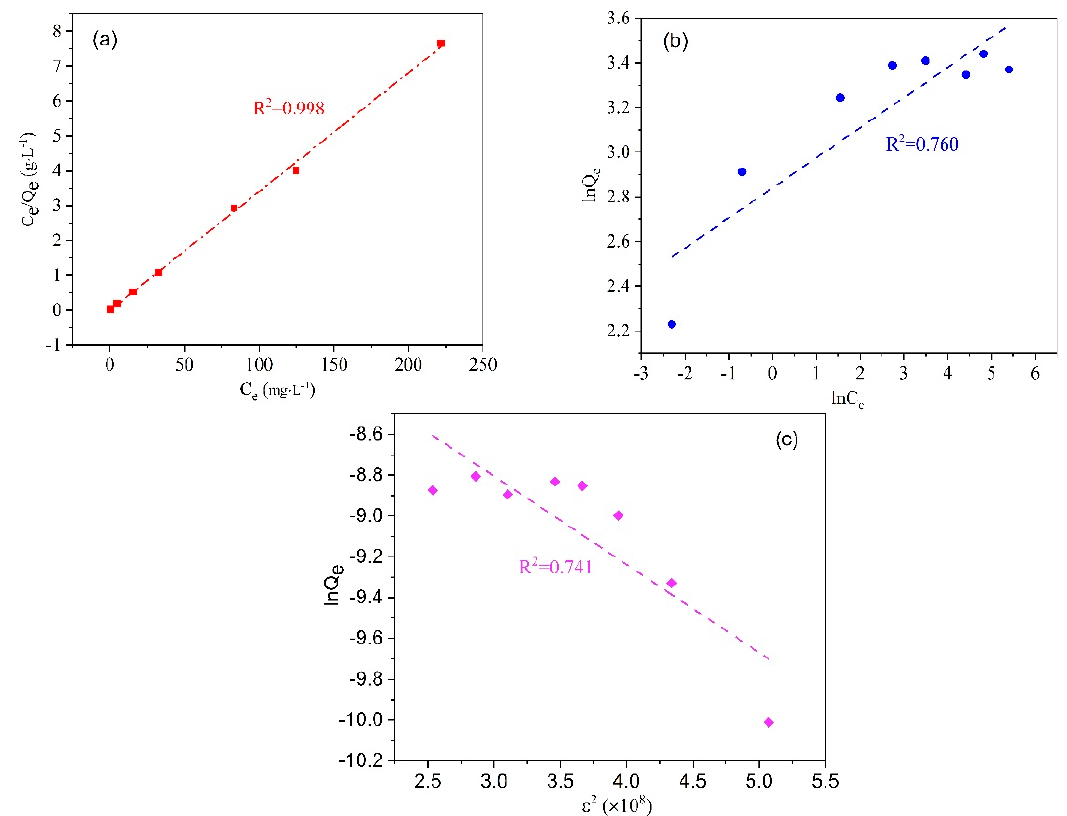
Figure 7. Linear fitting of Langmuir ( a ), Freundlich ( b ) and Dubinin–Radushkevich ( c ) isotherm for lead ion adsorption on pristine slag.